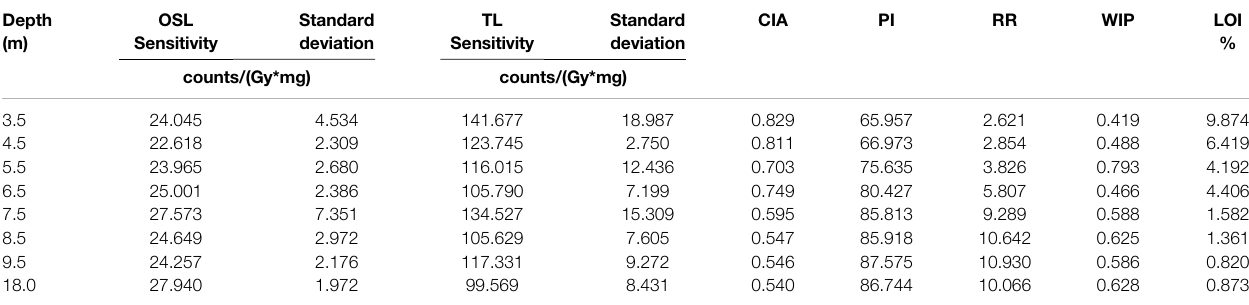
TABLE 5 | Quartz luminescence sensitivity and chemical weathering indices for samples from Sanming Borehole. Depth